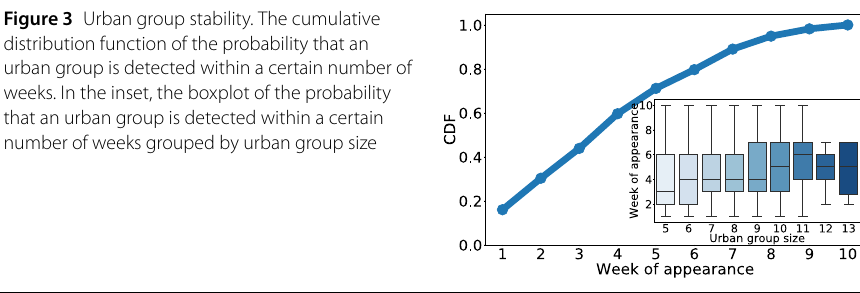
Figure 3 Urban group stability. The cumulative distribution function of the probability that an urban group is detected within a certain number of weeks. In the inset, the boxplot of the probability that an urban group is detected within a certain number of weeks grouped by urban group